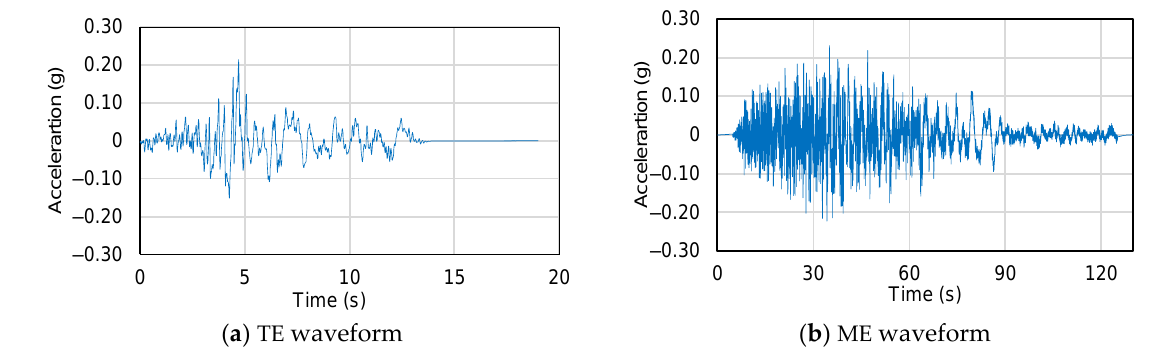
Figure 4. Input waveforms.